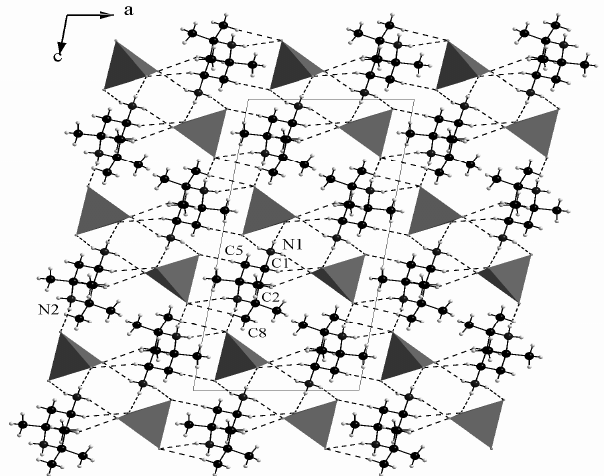
Figure 2. Projection of the structure of [C H N ]ZnCl along the b axis. ZnCl is given in 9 22 2 4 4 polyhedral representation. Hydrogen bonds are denoted by dotted lines The Zn(II) ion is in a tetrahedral coordination environment composed of four Cl - anions. Each ZnCl 42- group is connected to its four adjacent neighbour’s organic cations by N-H…Cl and C-H…Cl interactions involving four chlorine atoms (Table 3). The (N)-H…Cl distances, varying between 2.37 and 2.56 Ǻ , are smaller than the sum od Van der Waals radii of the chlorine and hydrogen atoms [r(Cl) + r(H) = 2.81 Ǻ ]. Consequently, these values correspond well to strong hydrogen bonds. However, the C-H…Cl hydrogen bonds play a subordinative role in stabilizing the structure 18, 19 . Moreover, the remarkable feature in the complexe salt is the N-H…Cl hydrogen bonding which form (((( )))) of hydrogen-bonded 26R 6 2 ring type 20 as shown in Figure 3.